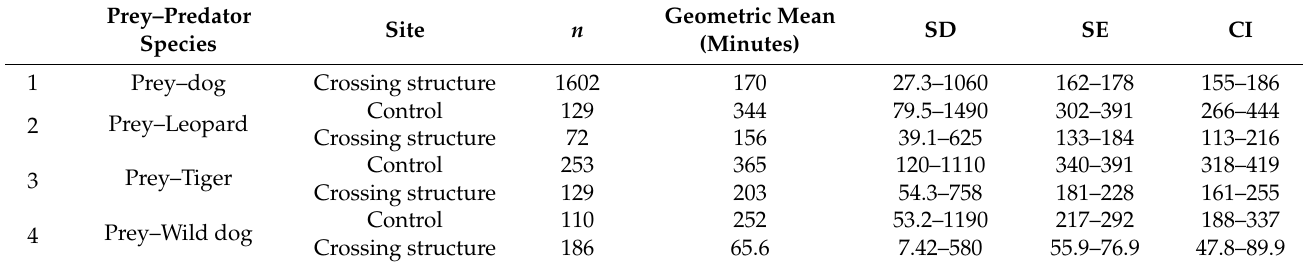
Table 2. Geometric mean latencies (minutes) between prey–predator sequences for different wild predator species and free-ranging dogs at crossing structures on NH 44, Pench Tiger Reserve, Maha- rashtra,